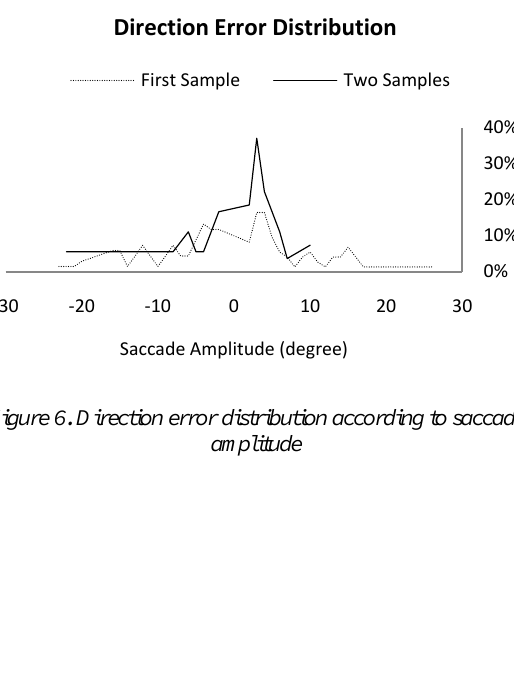
Figure 3. Scatter plots between actual saccade amplitude and predicted amplitude by the velocity model